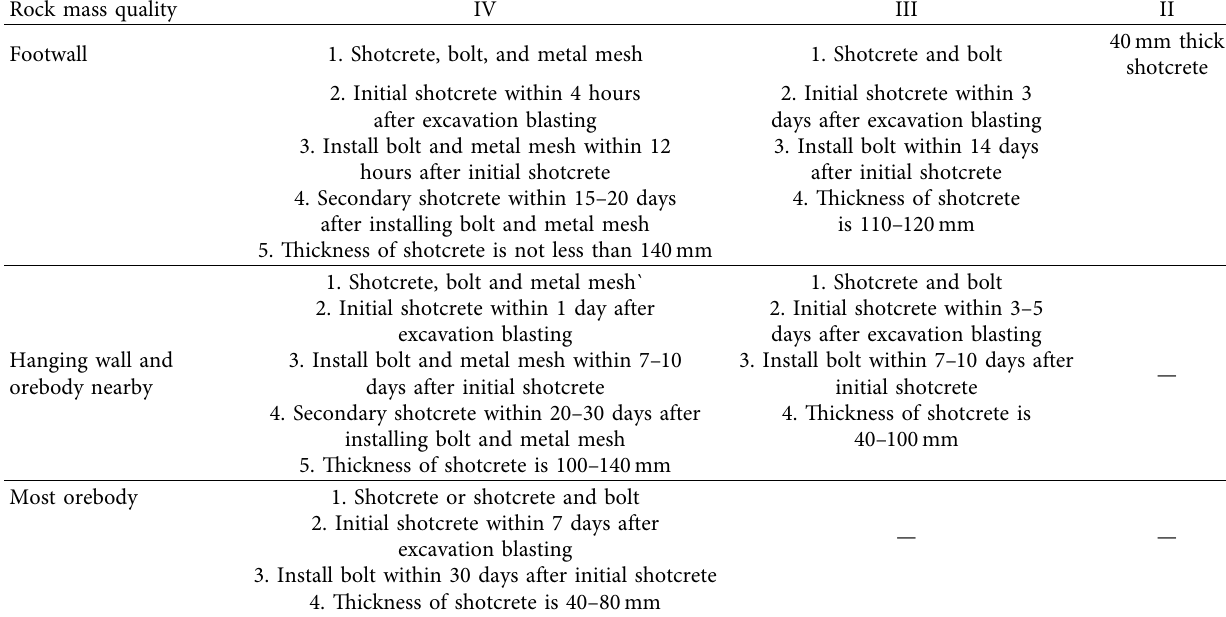
Table 4: Support improvement scheme of Xingshan iron